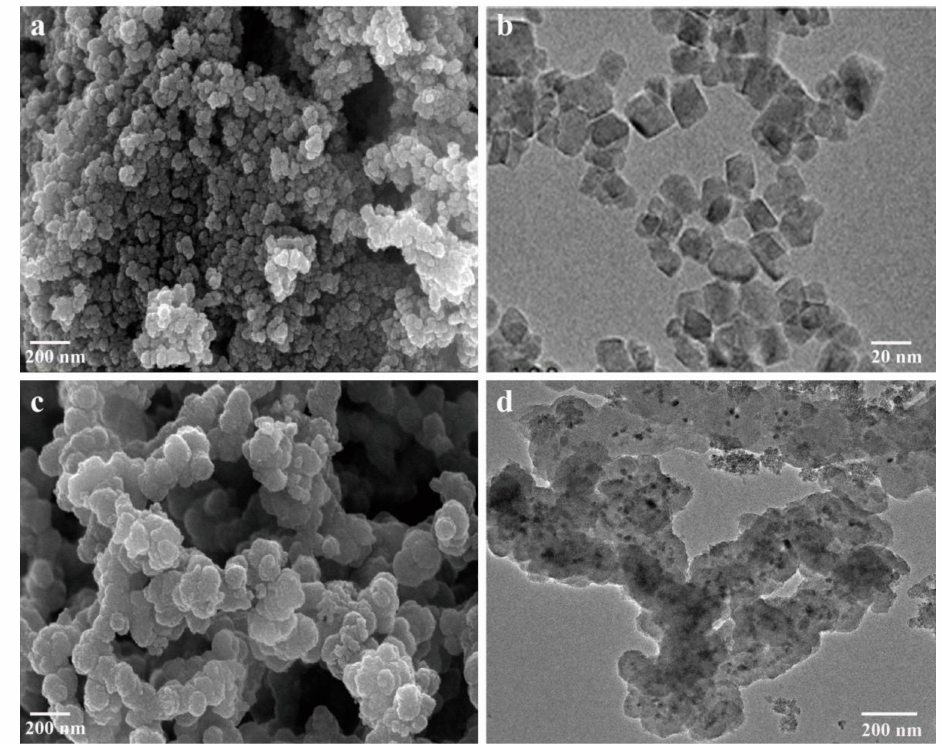
Figure 2. Microstructure of the Fe 3 O 4 @PPy composites under SEM and TEM. ( a ) SEM image of Fe 3 O 4 NPs. ( b ) TEM image of Fe 3 O 4 NPs. ( c ) SEM image of Fe 3 O 4 @PPy composites. ( d ) TEM image of Fe 3 O 4 @PPy